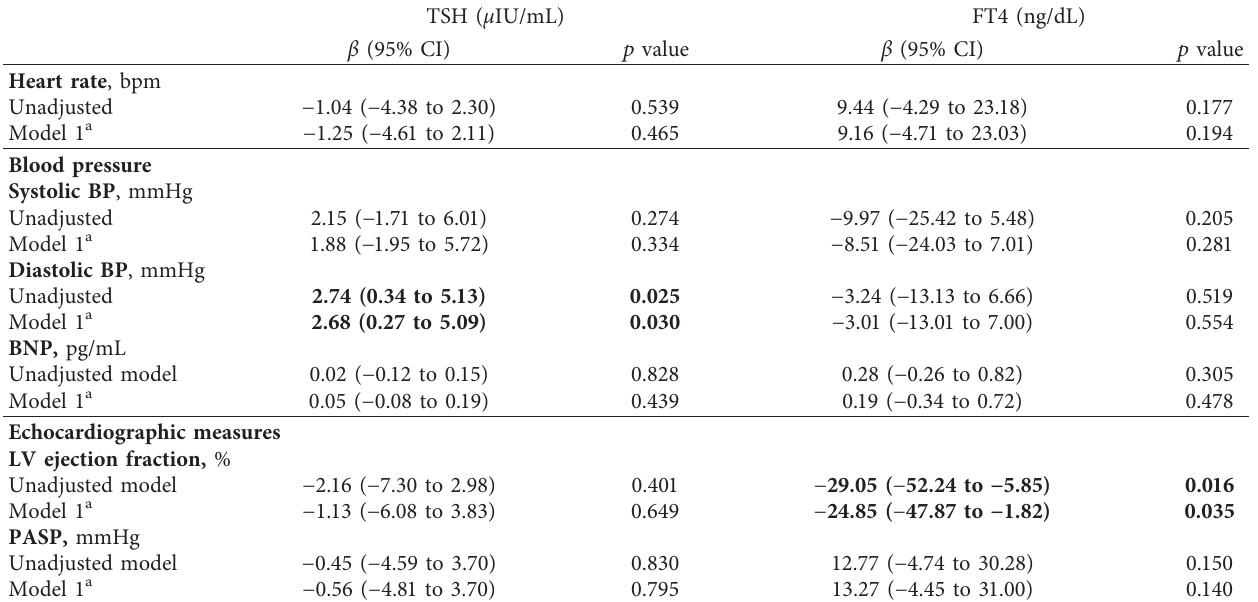
Table 2: Linear association of thyroid status (TSH and FT4) with cardiovascular function during